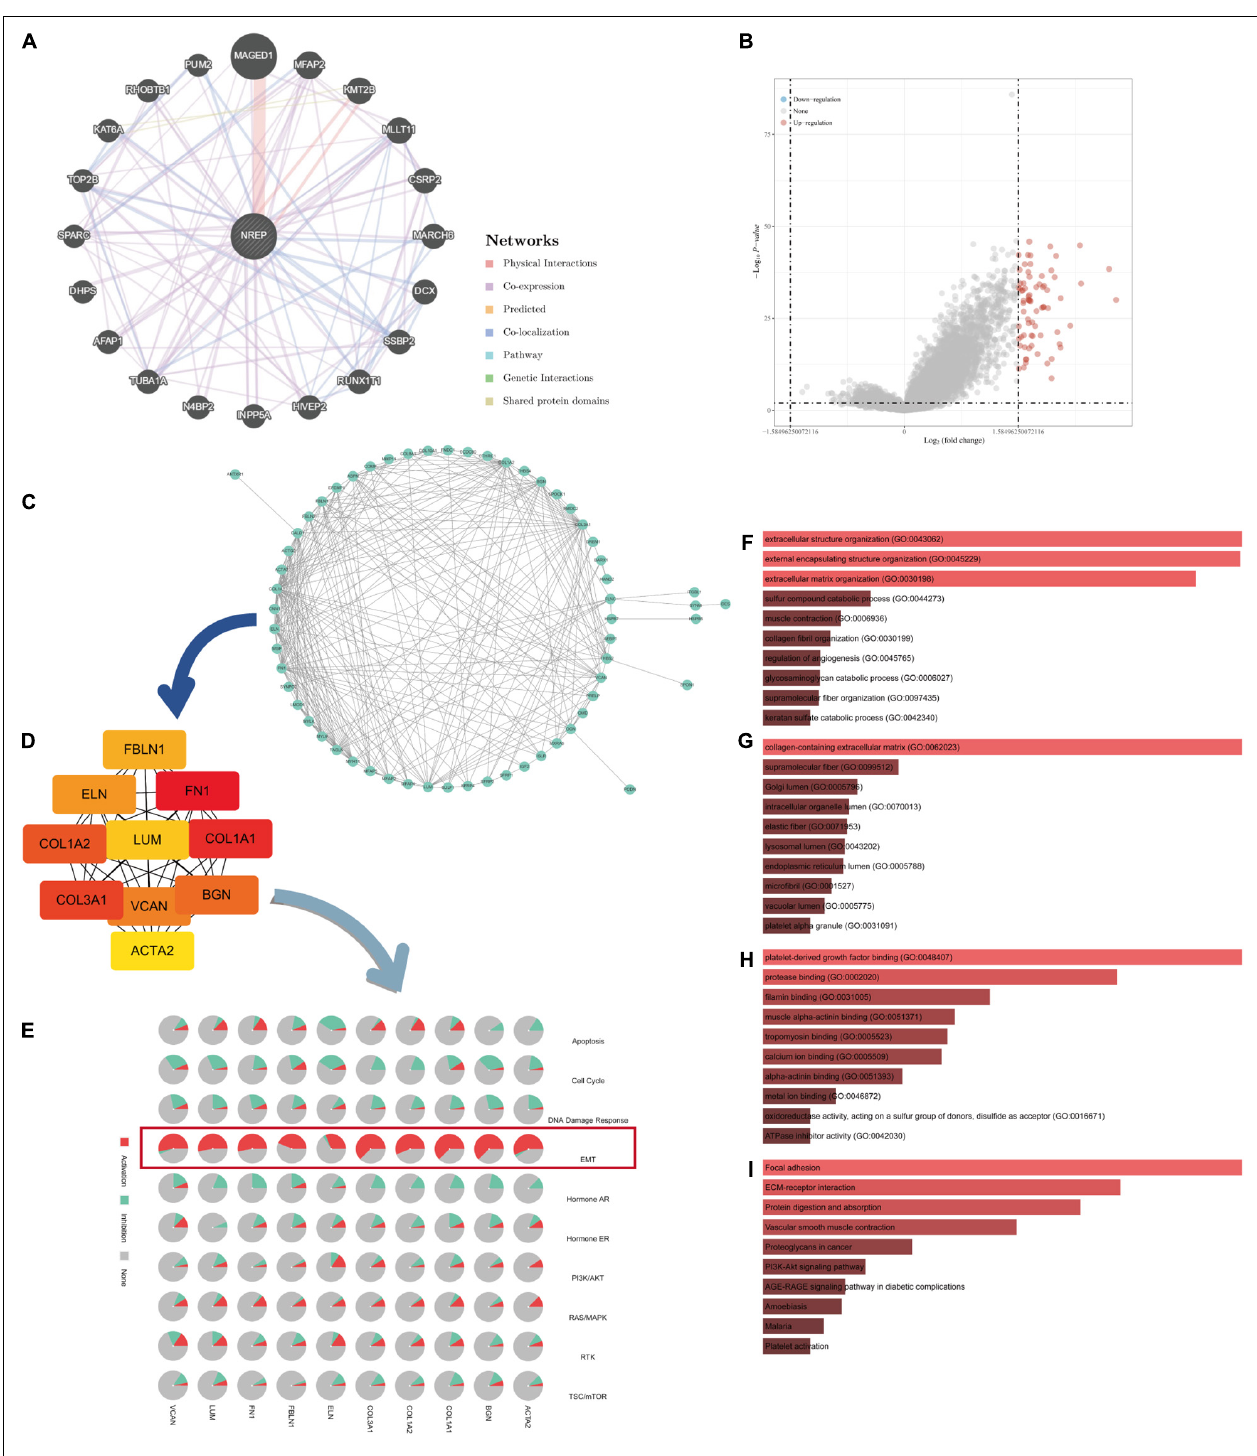
Frontiers in Cell and Developmental Biology |